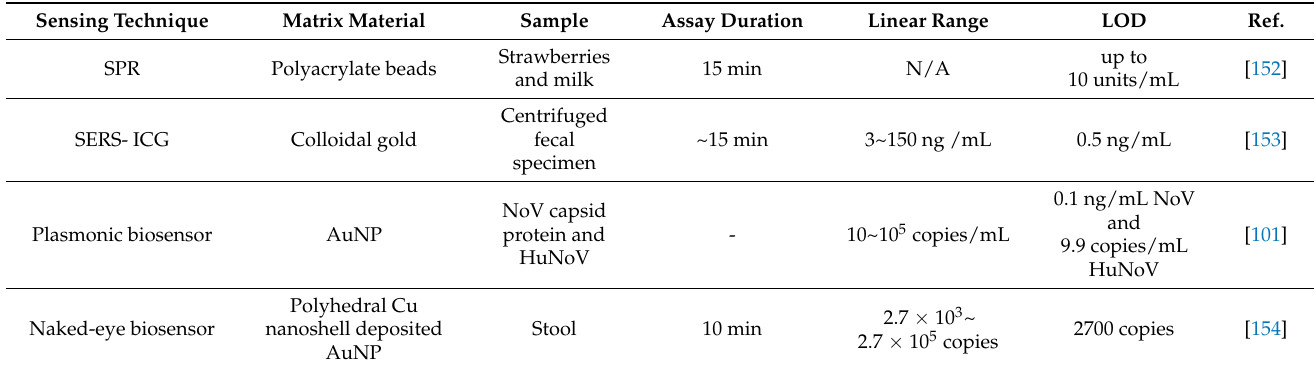
Table 3. The list of various biosensors used for norovirus